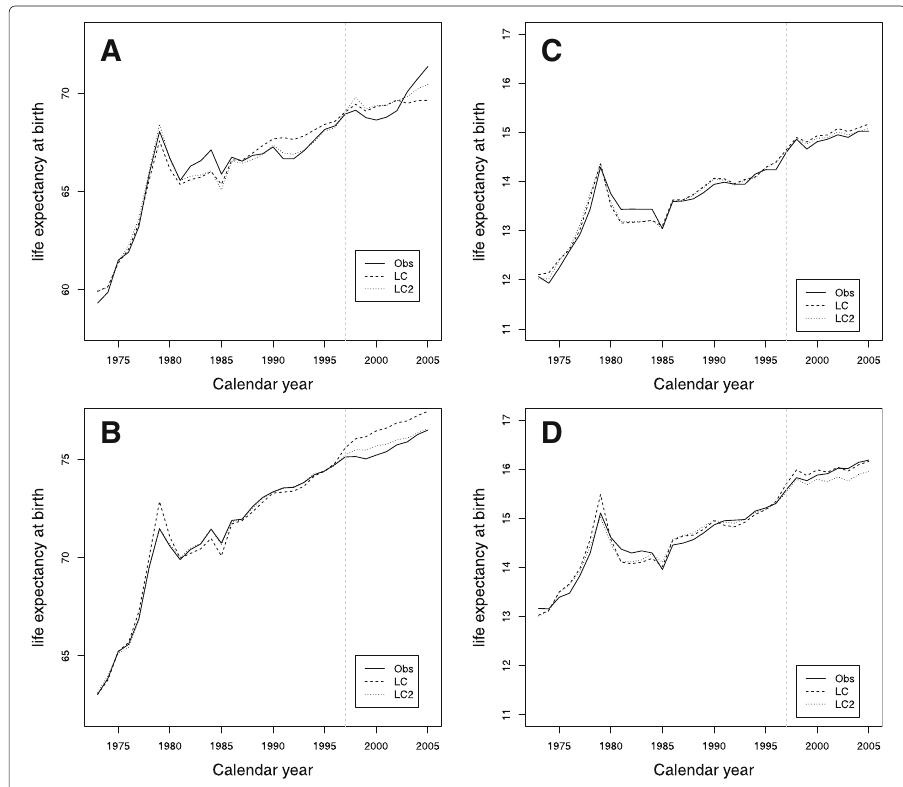
Fig. 2 Comparison of life expectancy for the training period 1973–1997 and the validation period 1998–2005. a Life expectancy at birth for men. b Life expectancy at birth for women. c Life expectancy at age 65 for men. d Life expectancy at age 65 for